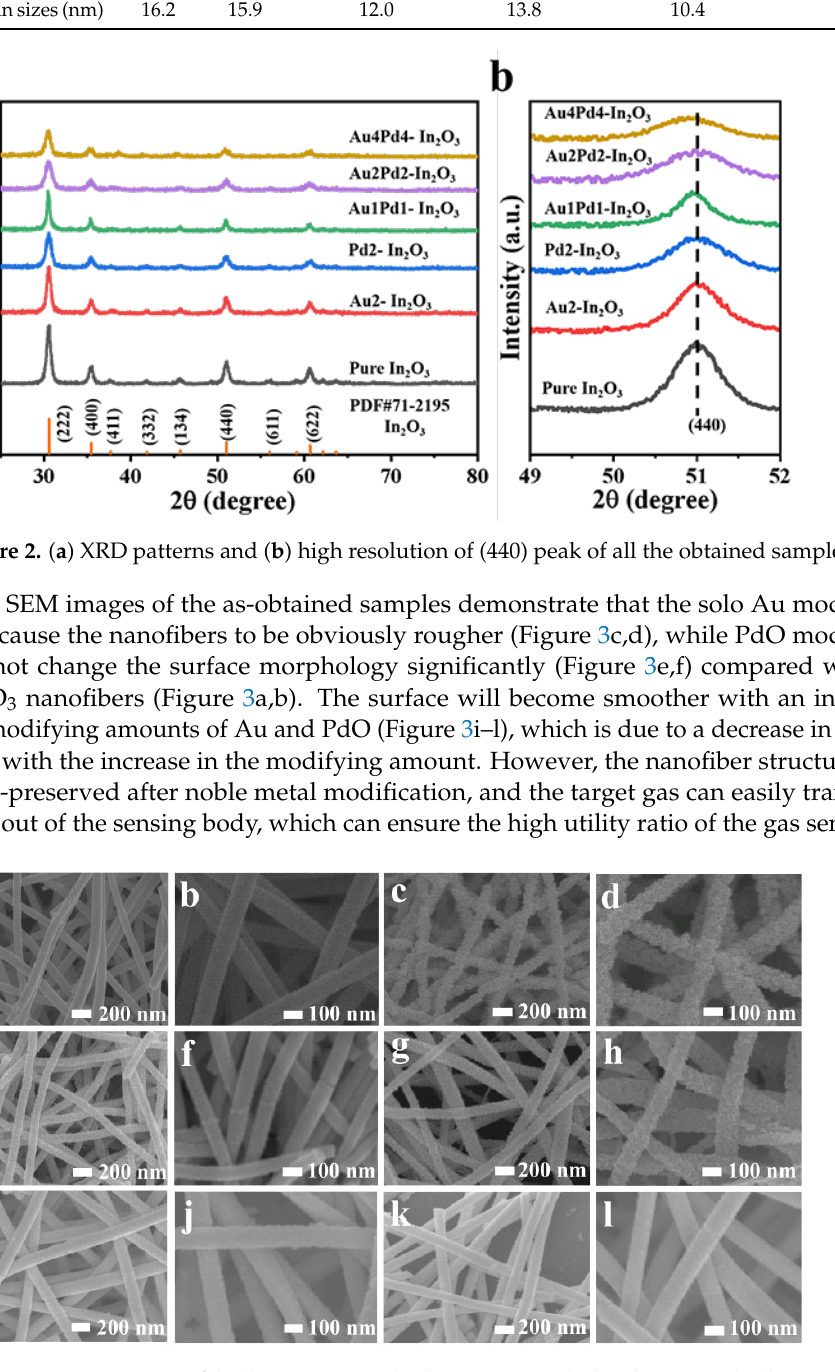
Figure 3. SEM images of ( a , b ) pure In 2 O 3 ; ( c , d ) Au2-In 2 O 3 ; ( e , f ) Pd2-In 2 O 3 ; ( g , h ) Au1Pd1-In 2 O 3 ; ( i , j ) Au2Pd2-In 2 O 3 ; ( k , l ) Au4Pd4-In 2 O 3 nanofibers. TEM images of pure In 2 O 3 (Figure 4a) and Au2Pd2-In 2 O 3 samples (Figure 4c) demon- strate that the surface of the nanofiber will become rougher after the addition of Au